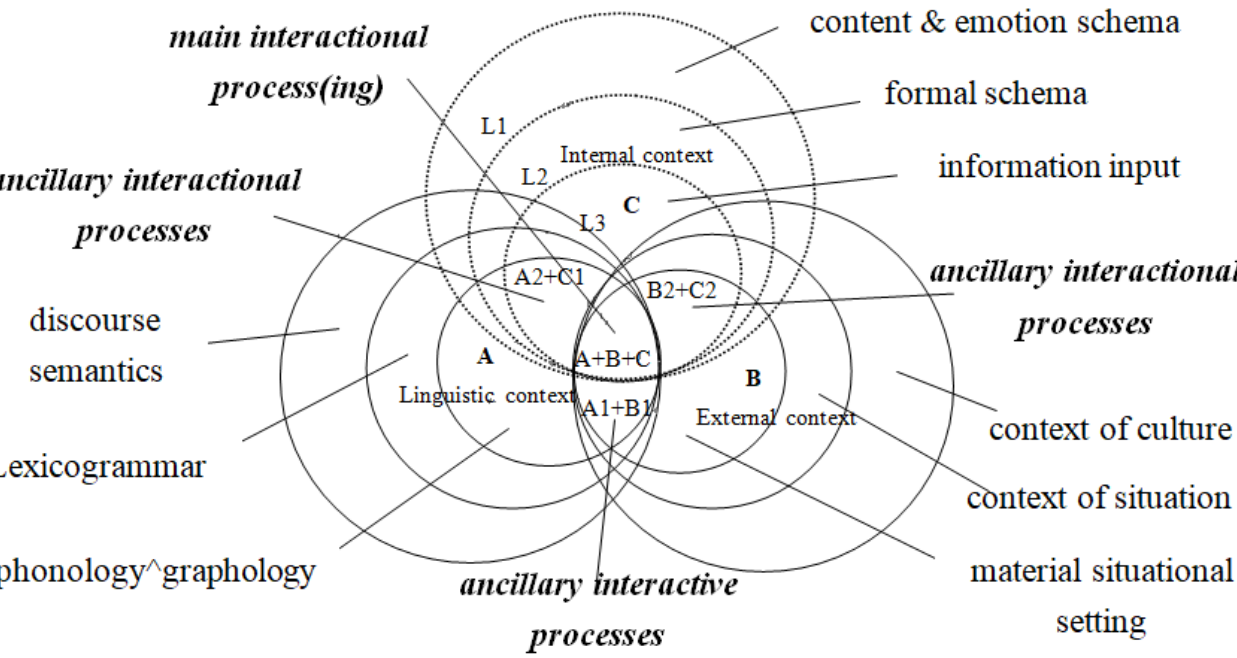
Figure 1. The Ecointeractive Context Model (^ = ‘ followed by ’